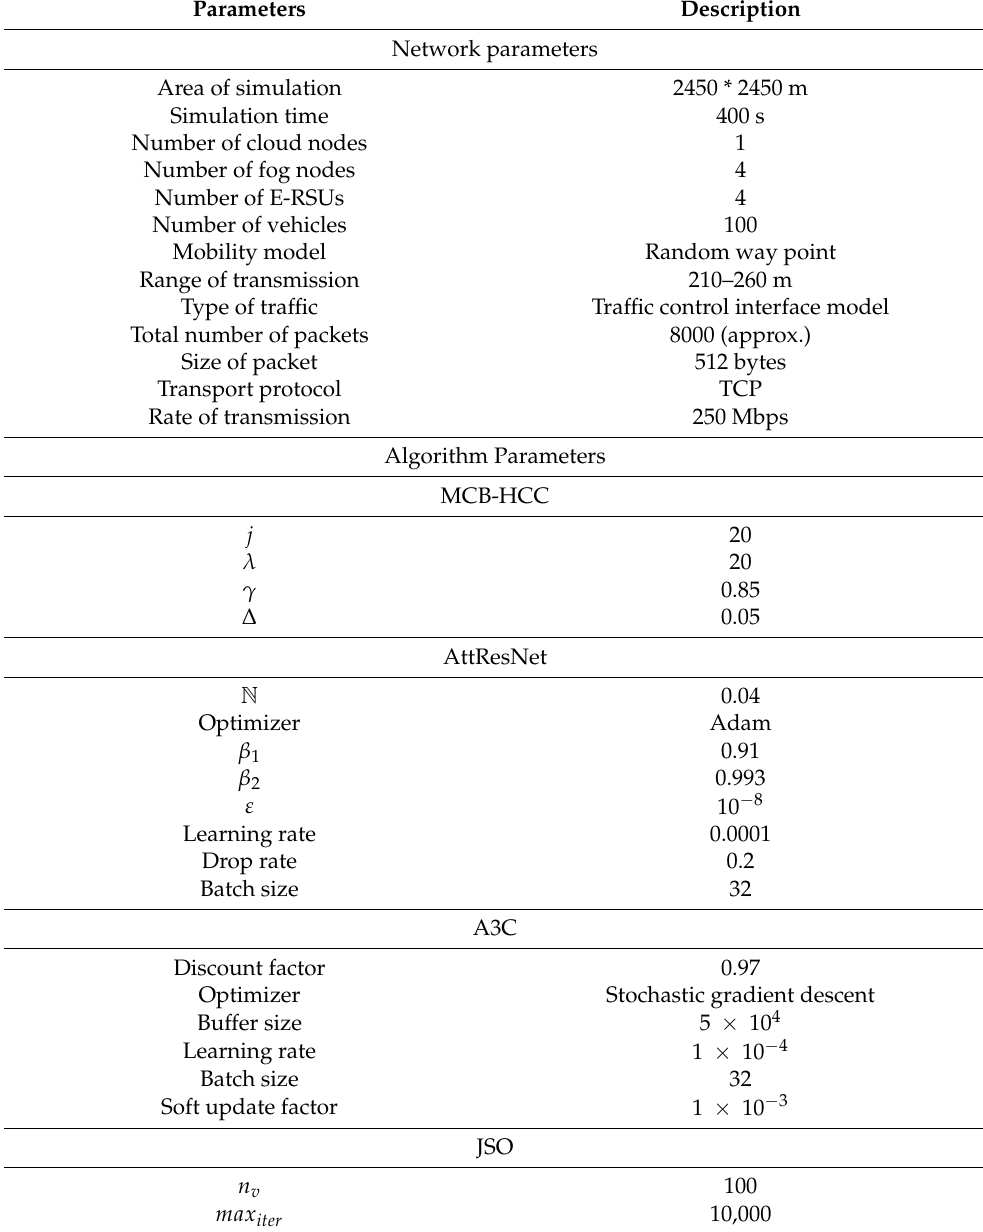
Table 3. Simulation